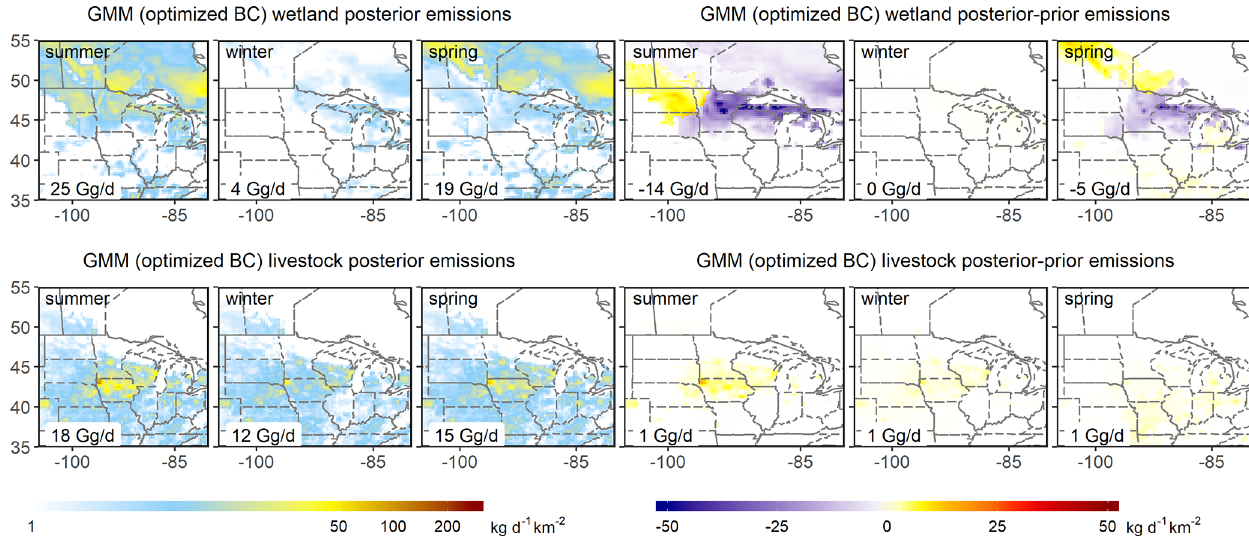
Figure 6. The same as Fig. 5 but showing results for the GMM inversions with boundary condition optimization.